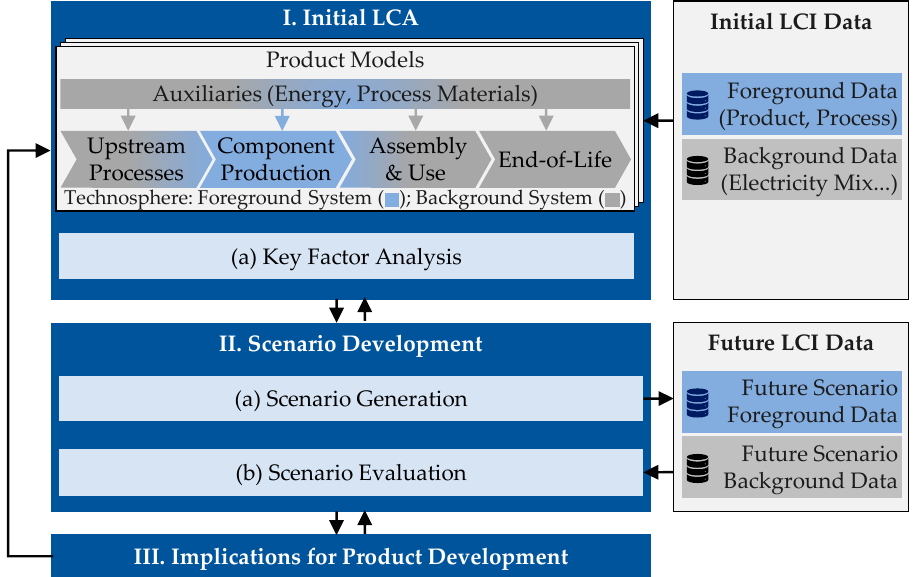
Figure 1. Methodological foundation for integrating prospective LCA in the LCE of lightweight structures comprising three steps.